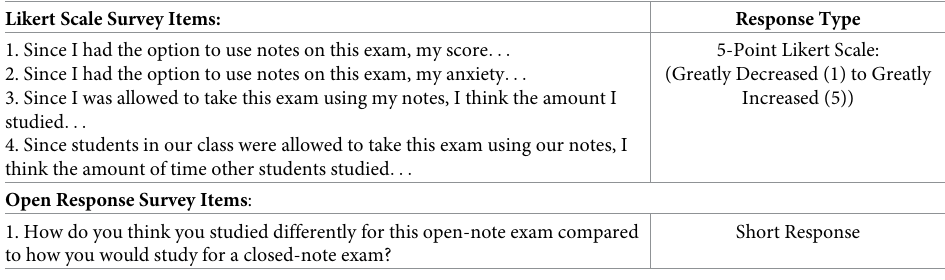
Table 1. The four 5-point Likert scale survey questions and answer choices used in this study. Likert Scale Survey